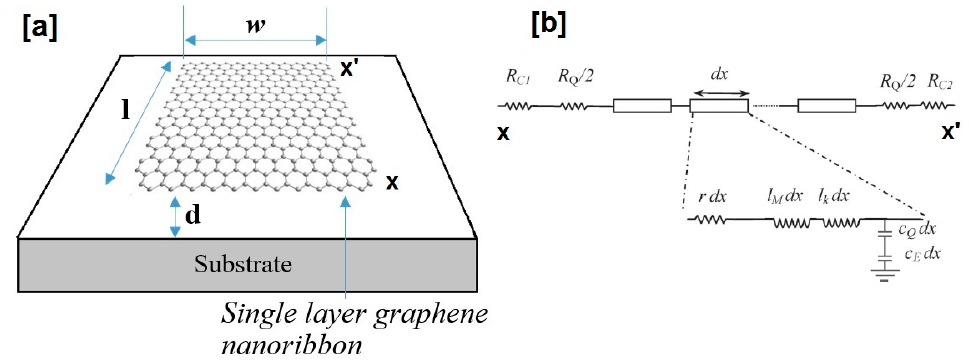
Figure 8. ( a ) Structure of single layer graphene interconnect; ( b ) resistive-inductive-capacitive (RLC) model for a single layer GNR interconnect [5]. Reproduced with permission from [5]. IEEE, 2009.